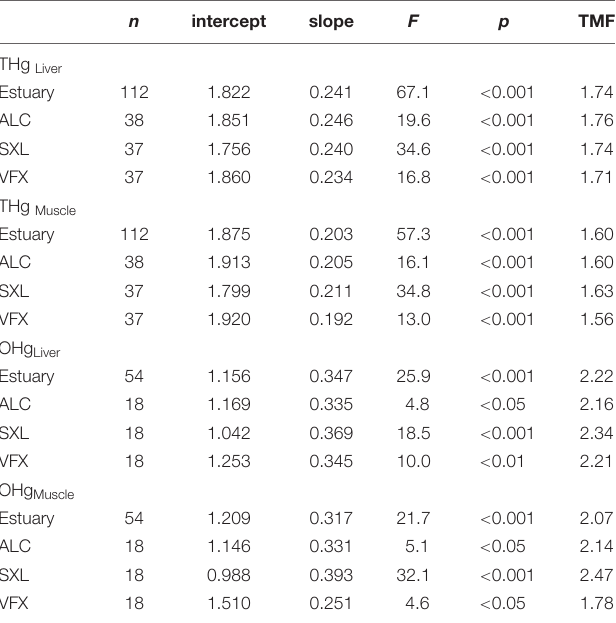
TABLE 3 | Regression analyses of log-transformed total (THg) and organic mercury (OHg) concentrations in estuarine organisms with species trophic level, per site (ALC, SXL, and VFX) and in the Tejo